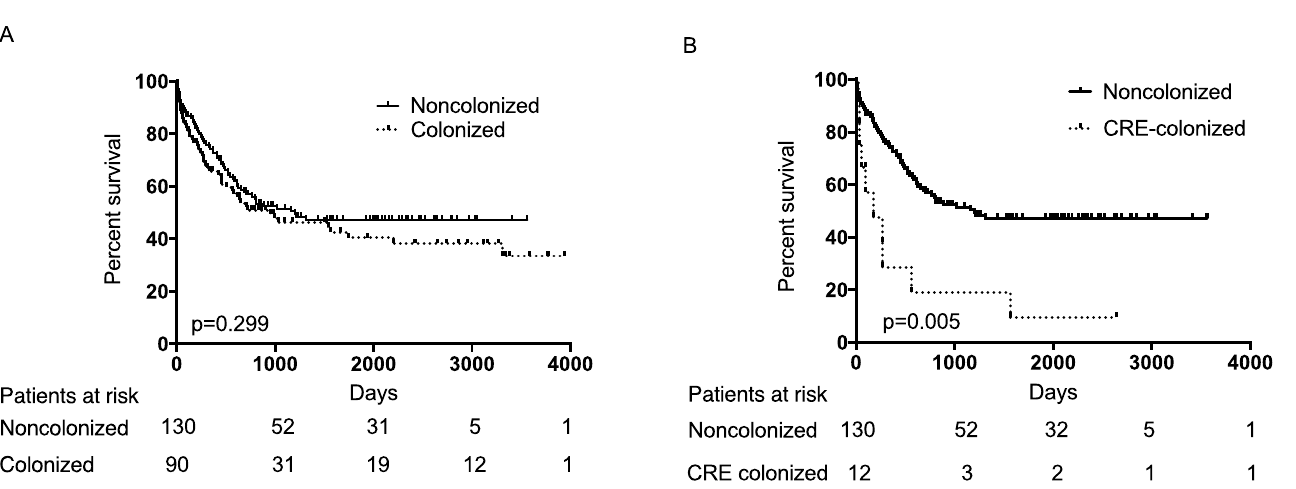
Fig 2. Kaplan-Meier curves for overall survival (OS). A. OS of colonized (dotted line) and noncolonized (solid line) patients. B. OS of CRE-colonized (dotted line) and noncolonized (solid line) patients.